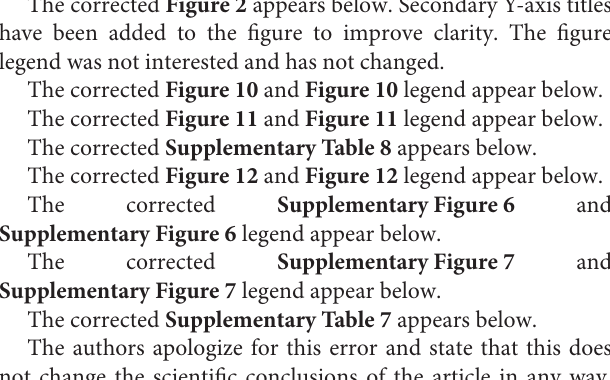
The corrected Supplementary Figure 6 and Supplementary Figure 6 legend appear below. The corrected Supplementary Figure 7 and Supplementary Figure 7 legend appear